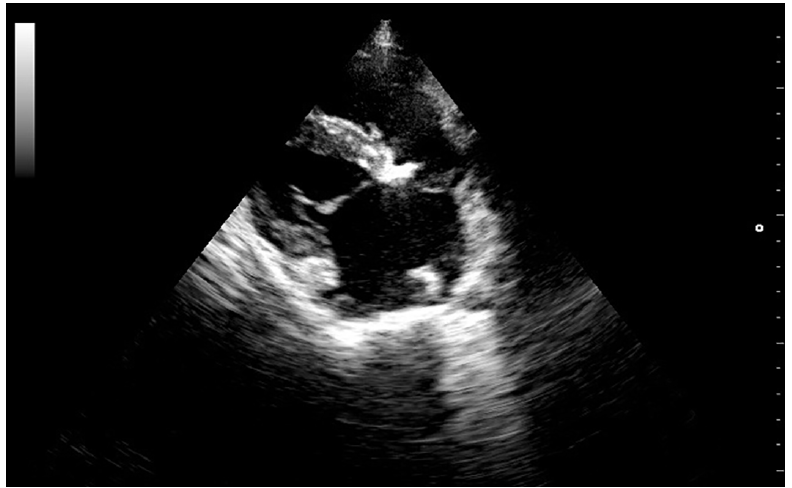
Figure 1. Right parasternal longitudinal 4-chamber view showing increased echogenicity and enlargement of the Mitral valve.